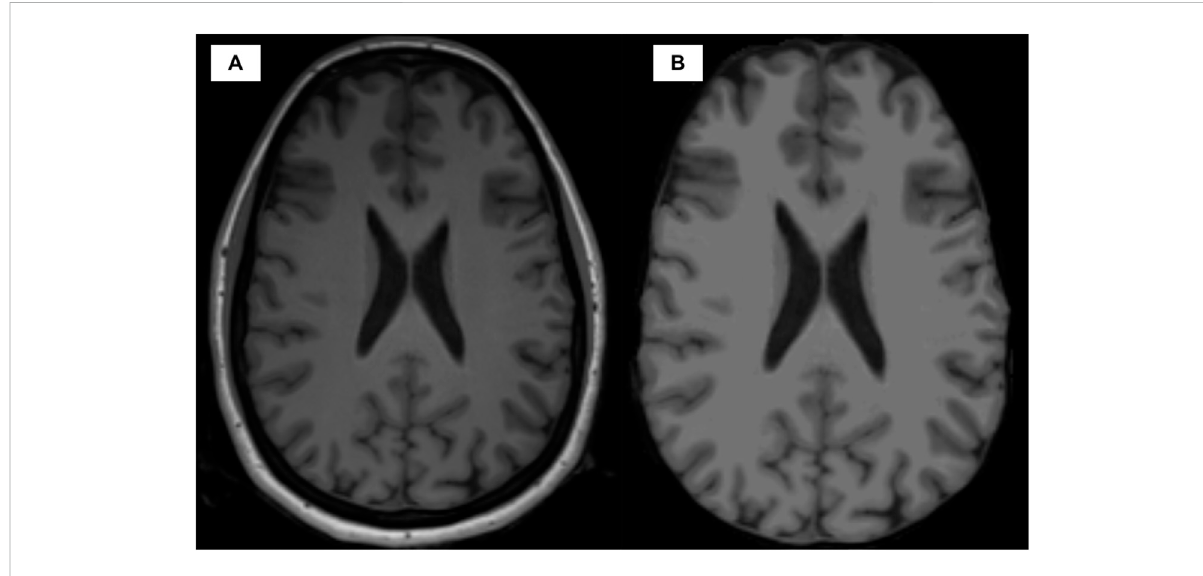
FIGURE 1 Visual comparison between the anatomical T1w image modality before (A) and after (B) preprocessing.